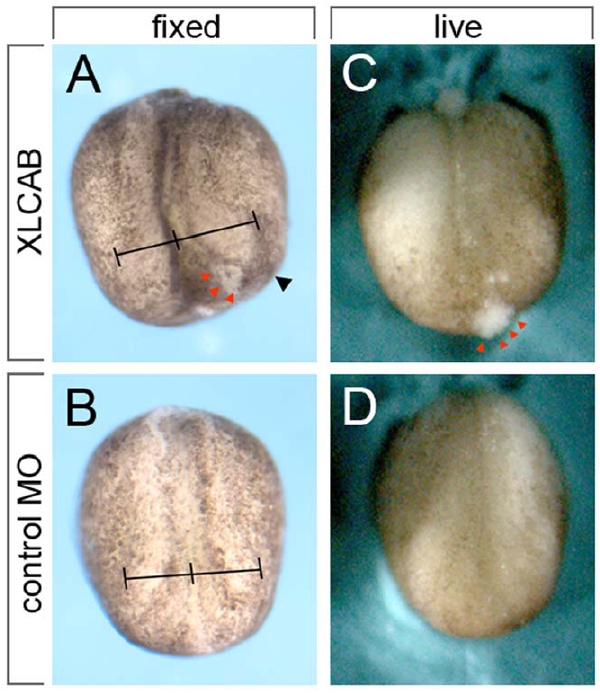
Figure 2. Disruption of neural fold morphogenesis in CRIM1 MO injected embryos. Pigmented embryos showed neural tube morphogenesis defects resulting from CRIM1 MO injection. In (A and B) line intervals mark the distance from the midline to the neural folds to emphasize the defect in morphogenesis that is a result of CRIM1 MO injection. In (A and C) red arrowheads indicate a region of cells that is sloughing from the embryo surface.